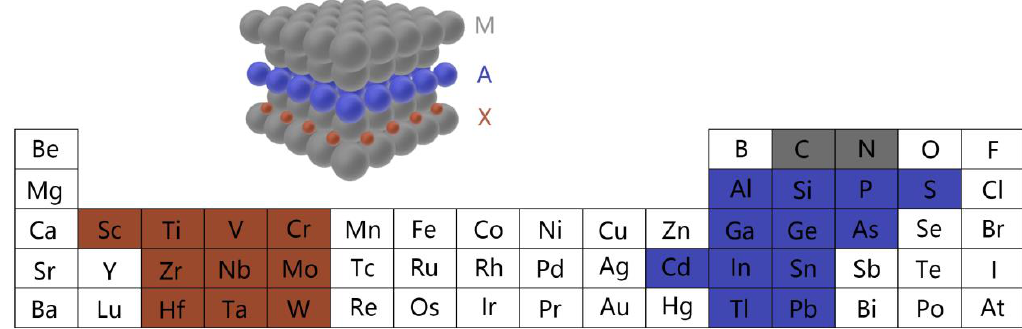
Figure 5. Fragment of the Periodic table. Elements forming MAX phases of the general